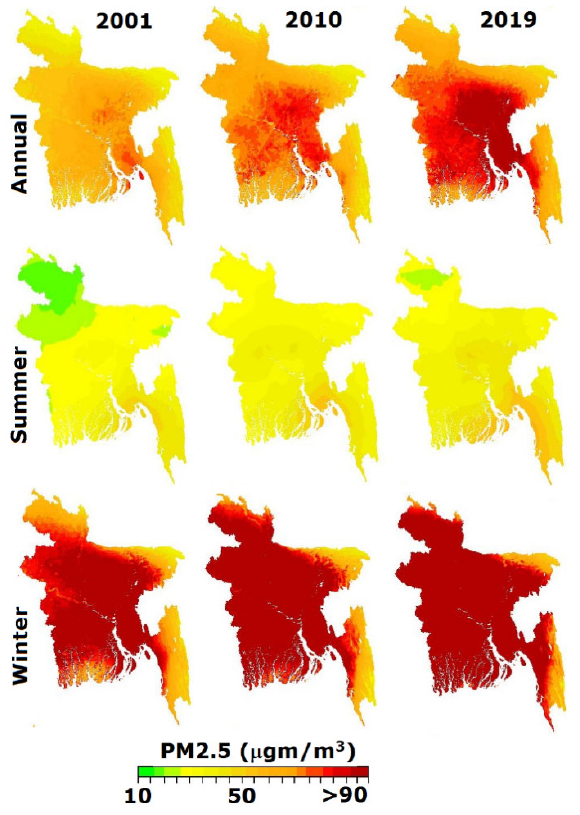
Figure 5 . Spatial distribution of annual, summer and winter PM 2.5 for three representative